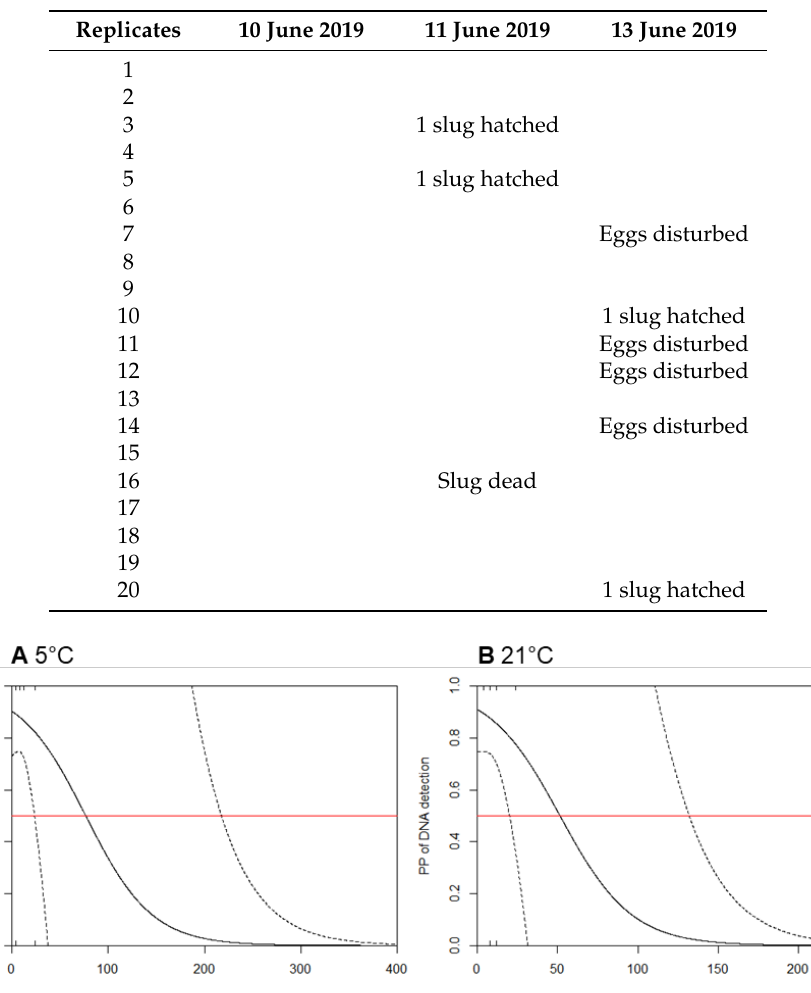
Table A2. Feeding trial 2 with 20 Nebria brevicollis kept at 16 ◦ C and a 12 / 12 light / dark cycle and presented with two Deroceras reticulatum eggs and a juvenile D. reticulatum (~0.05 g) each. The feeding trial was not checked on 12 June 2019.